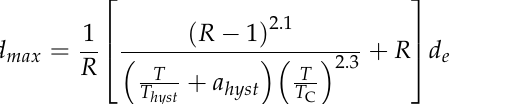
Table 2. Calibrated parameters for the proposed modified-N2 (MN2) equation